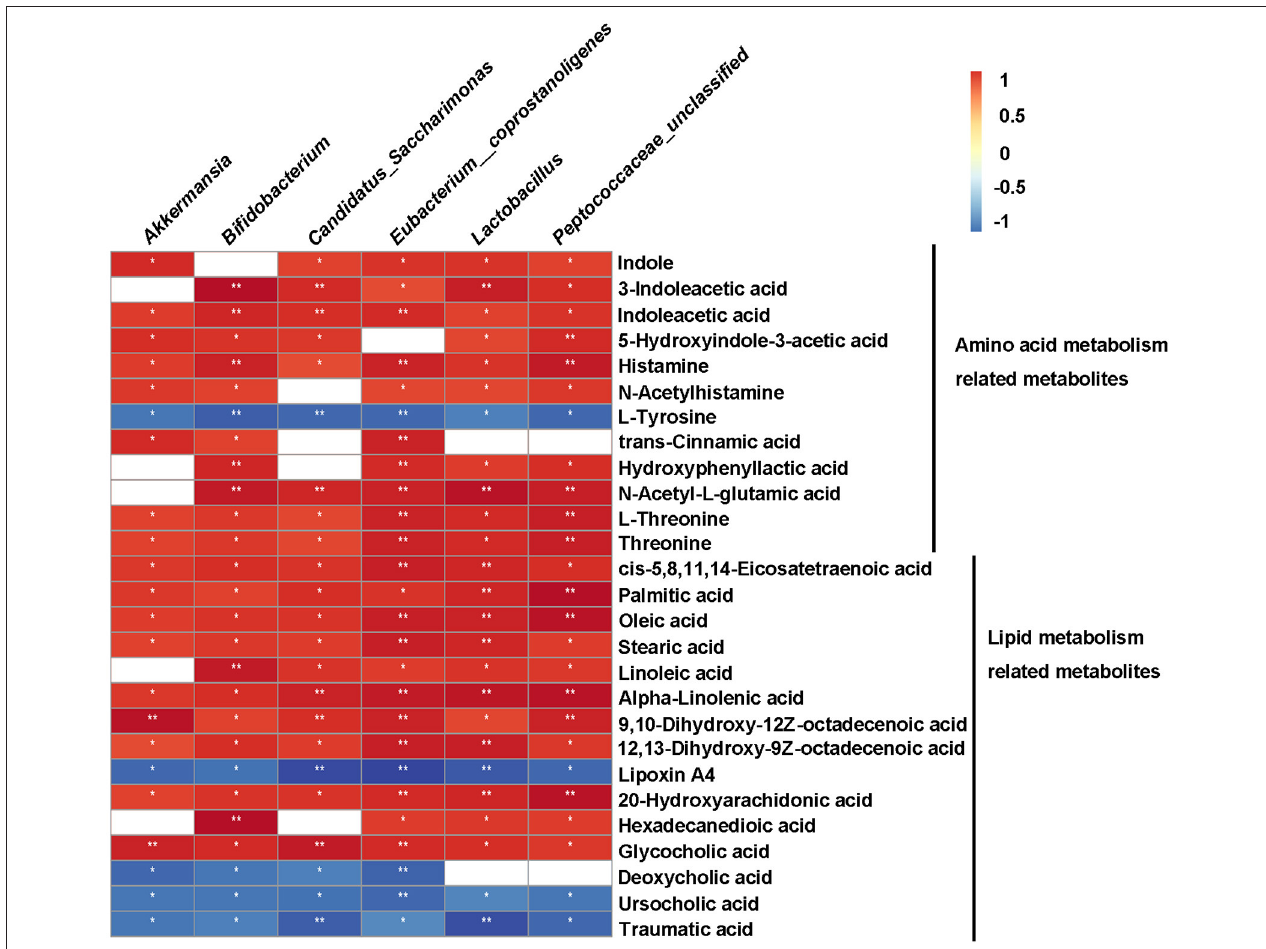
FIGURE 8 | Correlation between metabolites and bacteria (genus-level) enriched by WGQK. Red indicates positive correlation and black indicates negative correlation, the darker the color, the stronger the correlation. p -values of correlations were adjusted by false discovery rate (FDR). * p < 0.05, ** p < 0.01.